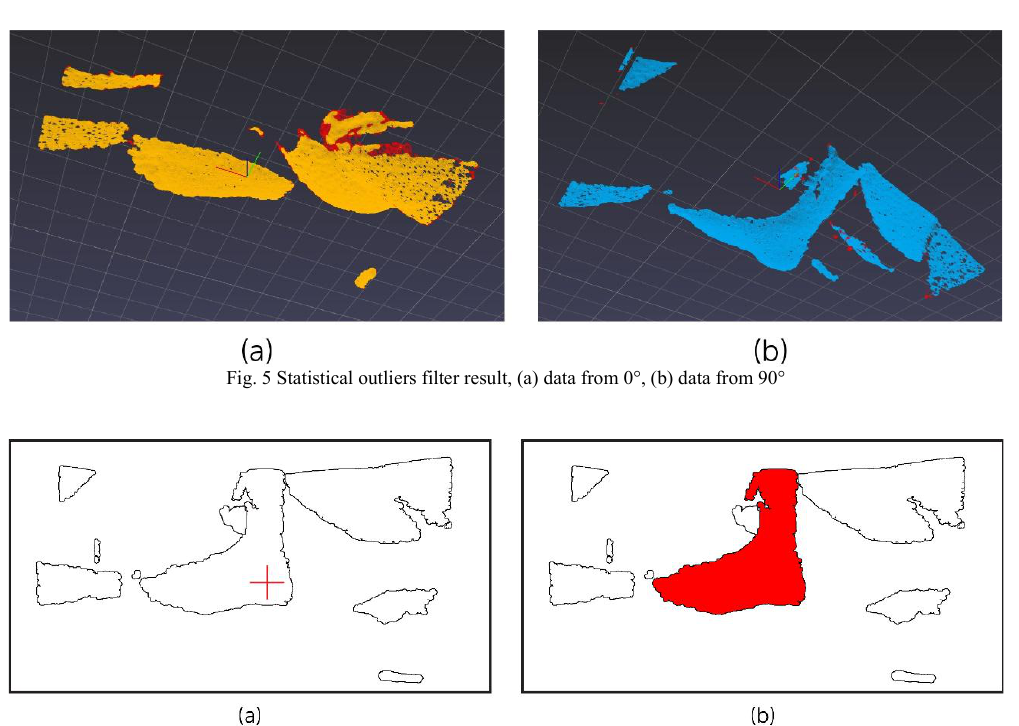
Fig. 6 Blob filter process, (a) blob selection, (b) blob filter result